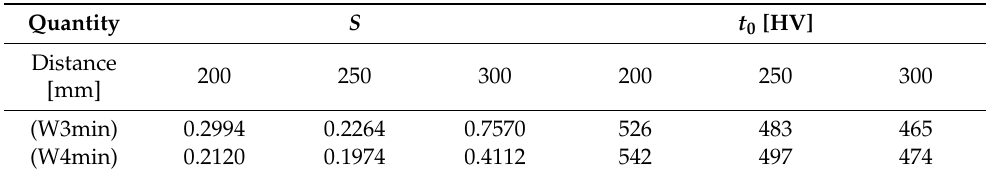
For the comparison of the fits based on the (W3max) and (W4max) CDFs, the times